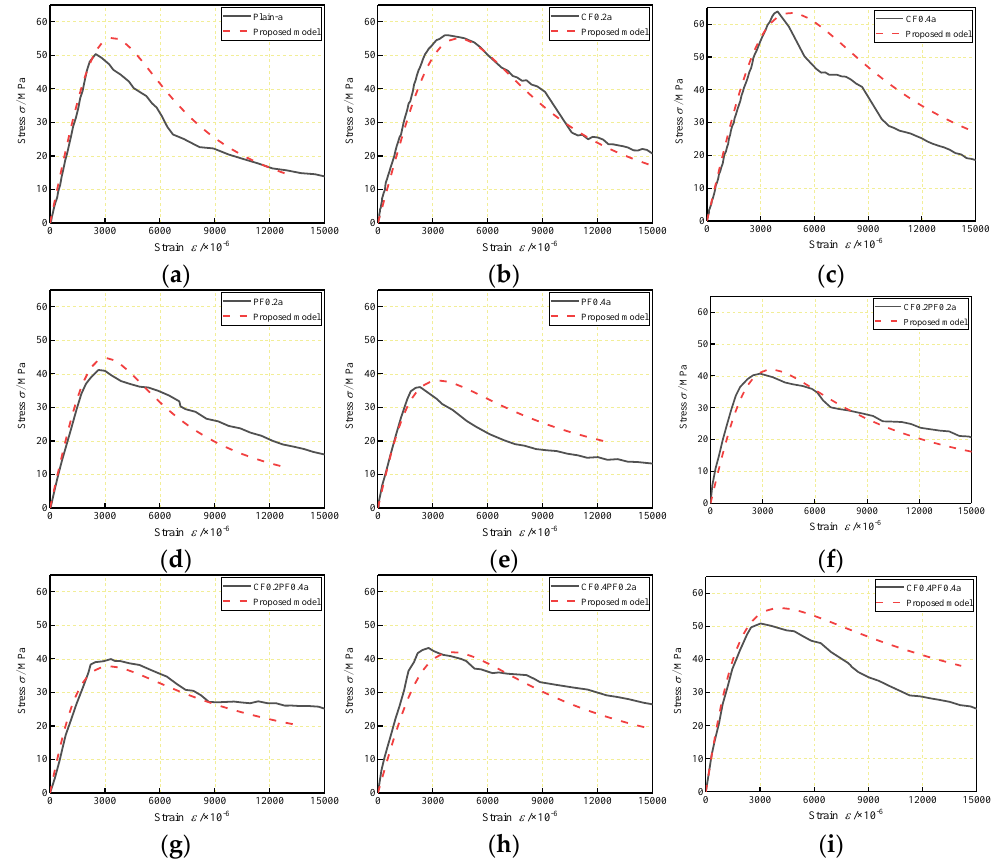
Figure 11. Comparison of calculated complete stress – strain curves for: ( a ) Plain – a; ( b ) CF0.2a; ( c )